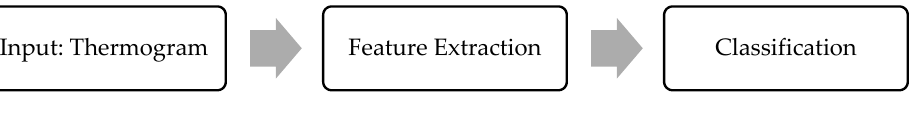
Figure 1. Methodology overview.